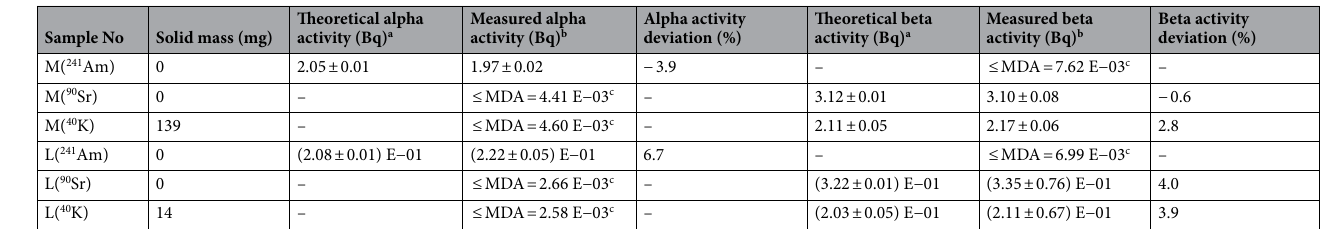
Table 4. Validation results of pure spiked samples of 40 K, 241 Am, and 90 Sr/ 90 Y standard solution. a Data obtained by multiplying the activity of the standard solution and the mass added. The expanded uncertainty corresponds to k = 1. b The expanded uncertainty corresponds to k = 1. c MDA (minimum detectable activity,